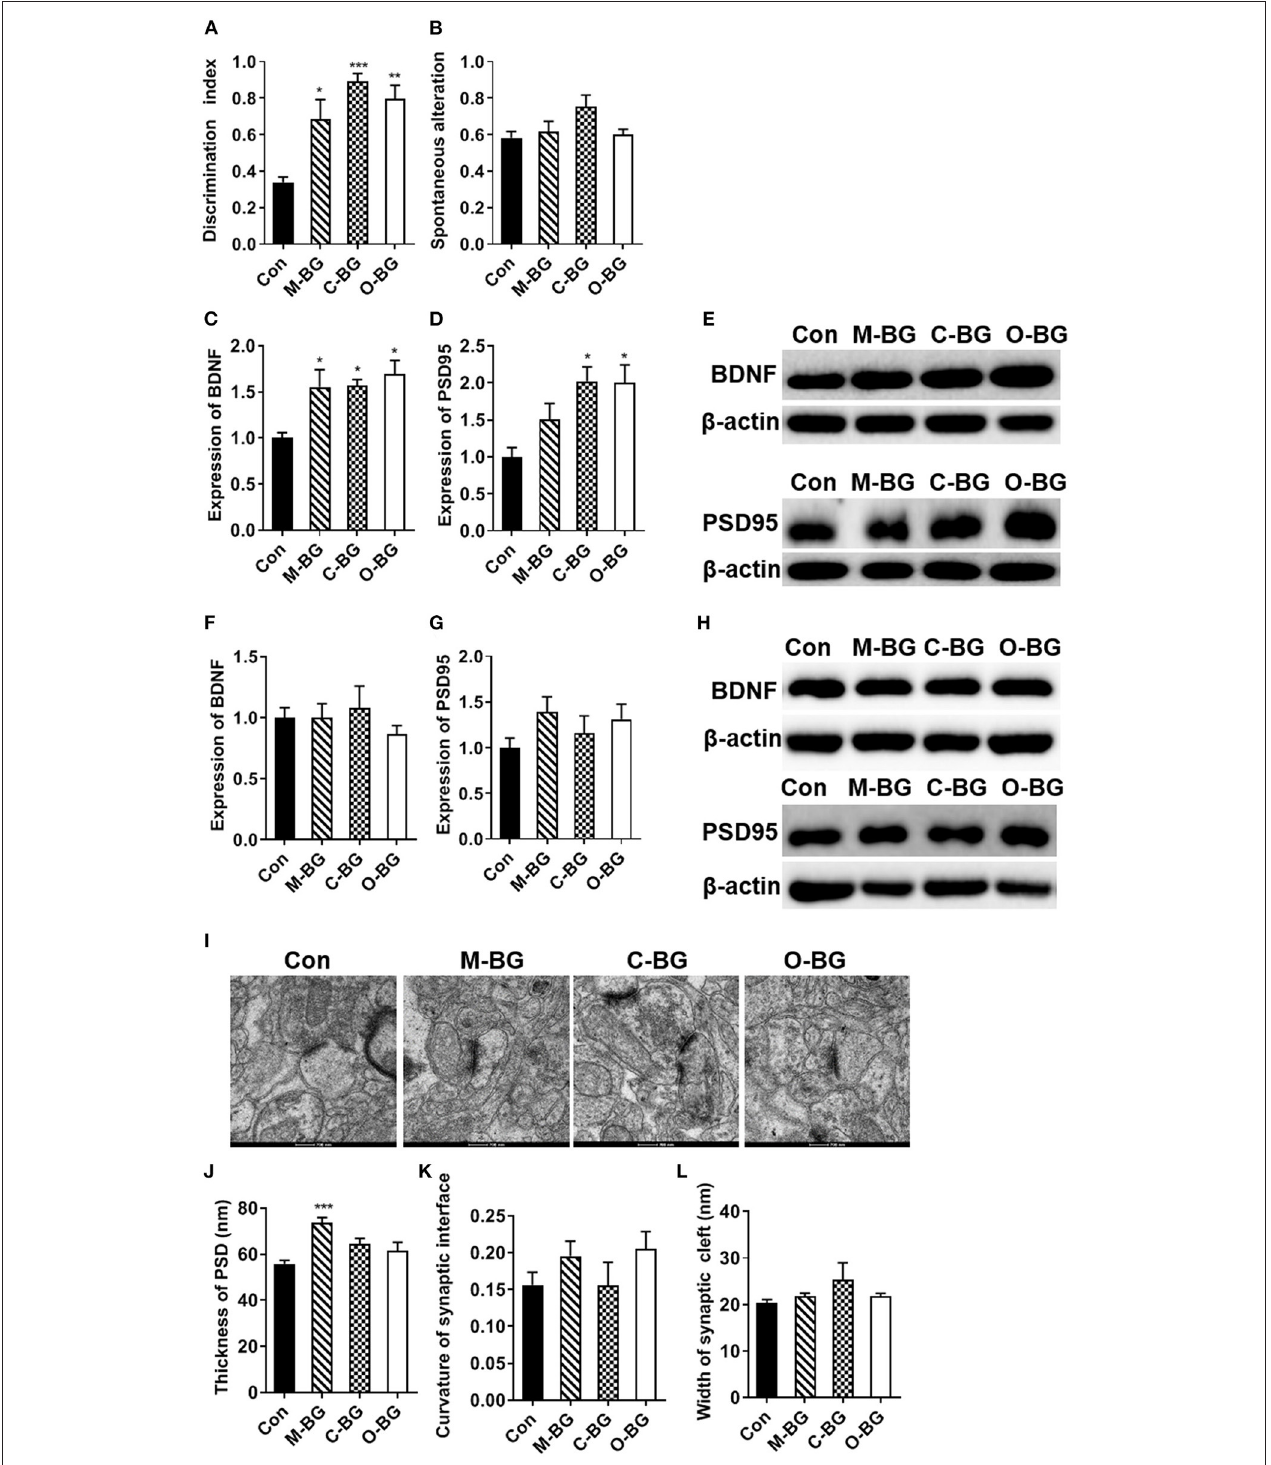
FIGURE 1 | Chronic β -glucans supplementation improved cognition and synaptic plasticity. (A) Discrimination index in the temporal order memory test, n = 6. (B) Proportion of correct alternations in the Y-maze test, n = 6. (C–E) The protein expression levels of BDNF and PSD95 in the PFC, n = 4. (F–H) The protein expression levels of BDNF and PSD95 in the hippocampus, n = 4. (I) Electron micrograph of synaptic ultrastructure in the PFC, n = 6. (J–L) Image analysis of the thickness of PSD (J) , the curvature of the synaptic interface (K) , and width of synaptic cleft (L) in the PFC. Data were presented as mean ± SEM. * P < 0.05 vs. Control, ** P < 0.01 vs. Control, *** P < 0.001 vs. Control. Scale bar: 200nm.